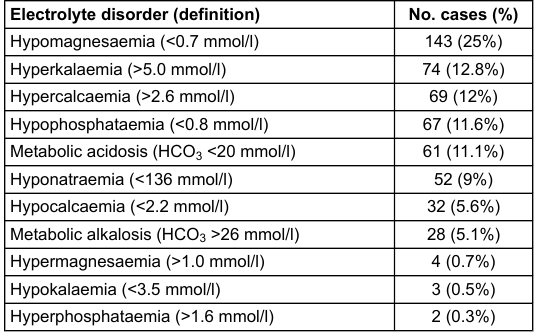
Table 2: Proportional distribution of acid-base and electrolyte disor- ders in the study population. Electrolyte disorder (definition)